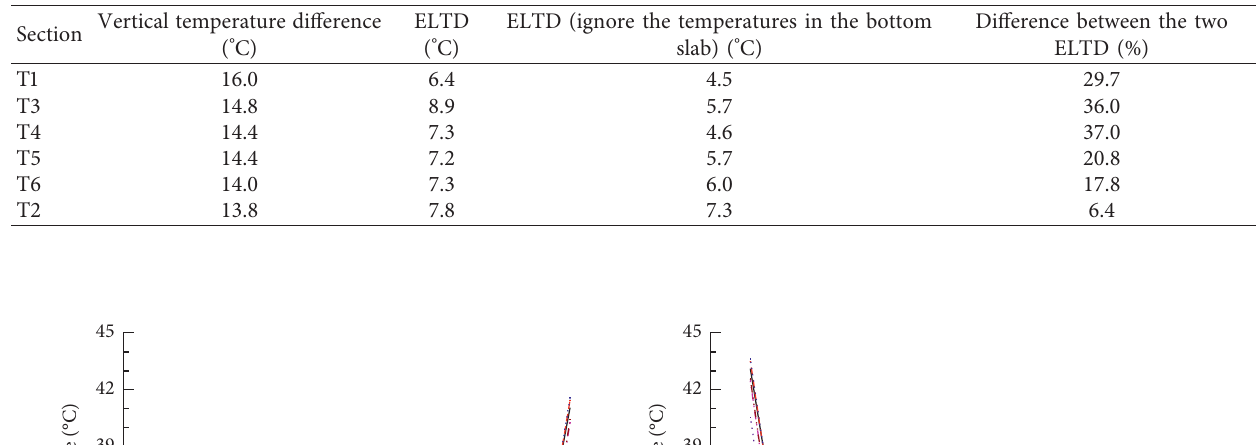
Table 3: The predicted maximum vertical temperature difference and its equivalent linear temperature difference in the girder at the six cross-sections.